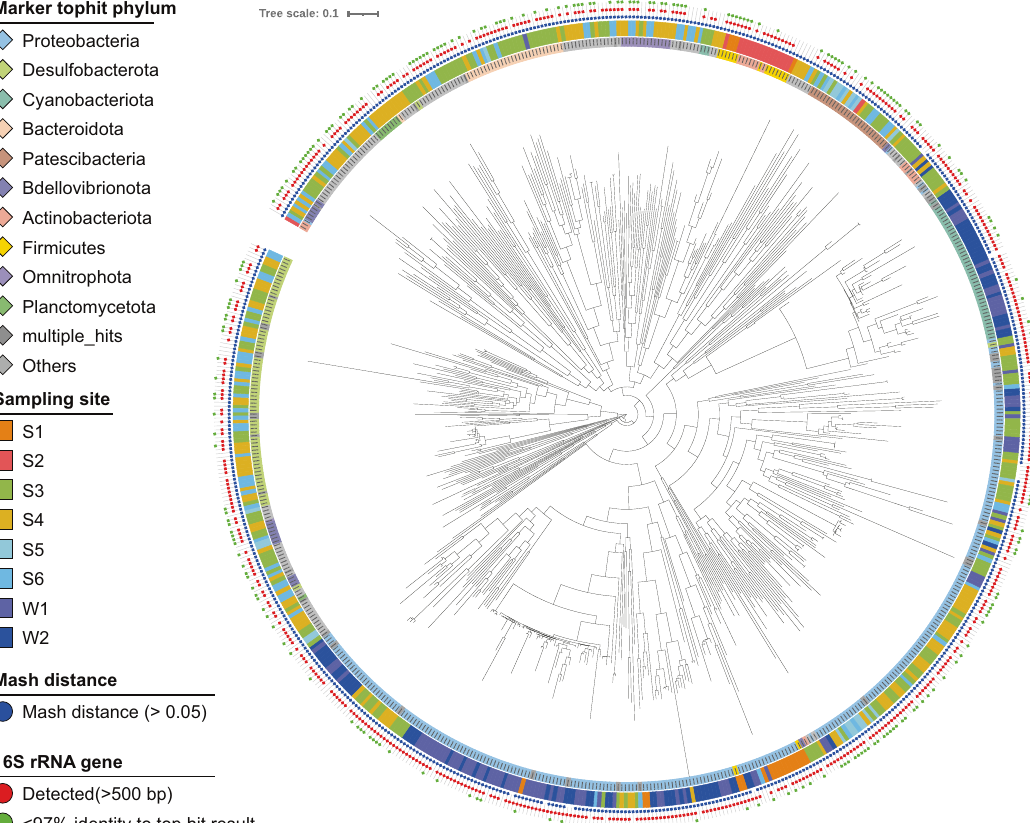
Fig. 3 Taxonomic classi fi cations of SAGs collected from environmental samples. The GTDB-Tk phylogenetic tree showing the taxon of 639 bacterial SAGs at the phylum level. Inner color bar: Top hit phylum; outer color bar: sampling site; blue dot: >0.05 Mash distance to the closest genomes in Refseq; red dot: 16S rRNA gene detected; green dot: <97% identity of 16S rRNA sequence to the top hit result. Any phyla that were not included in the top ten phyla were clustered as “ others ”